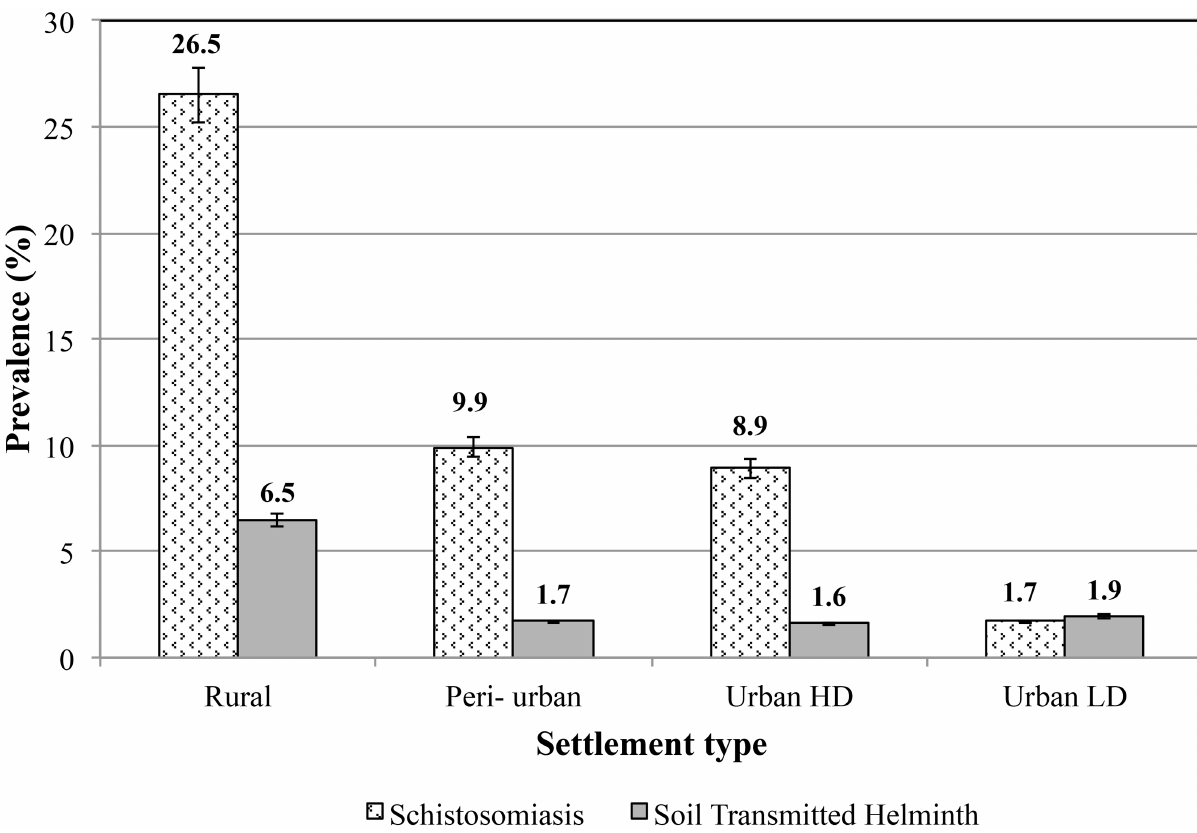
Prevalence category